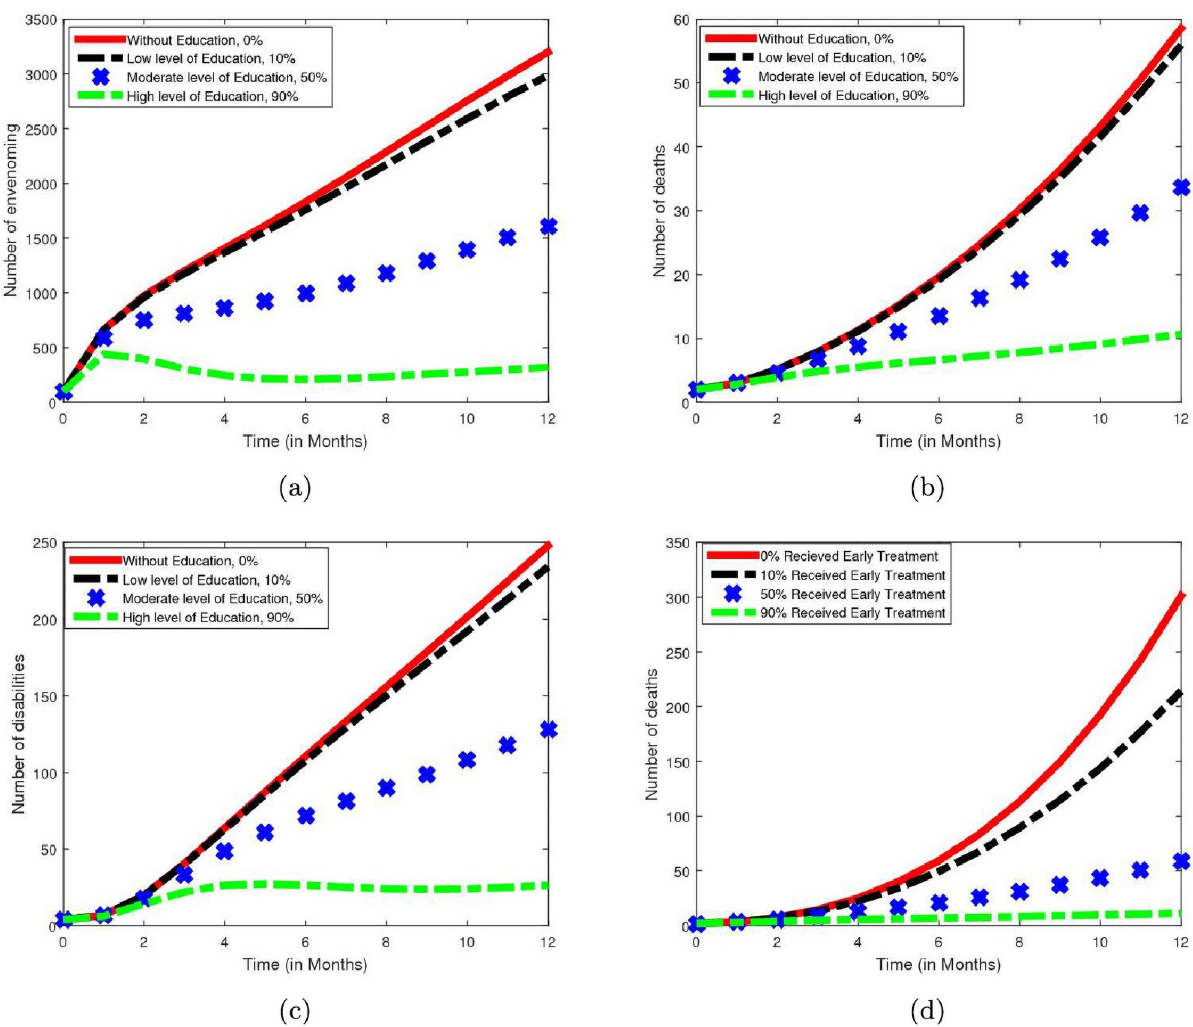
Fig 4. Simulations showing the impact and effectiveness of public health awareness and early treatment. The graphs clearly show the impact and effectiveness of public health awareness in averting number of (a) snakebite envenoming (b) snakebite induced death (c) disability. While (d) shows the impact of early treatment with antivenom on snakebite induced death. In Fig 4A, 4B and 4C the red, black, blue and green colors correspond to 0%, 10%, 50% and 90% public health awareness campaign coverage and its efficacy, respectively. In Fig 4D, the red, black, blue and green colors represent 0%, 10%, 50% and 90% of envenoming individuals receiving early treatment with